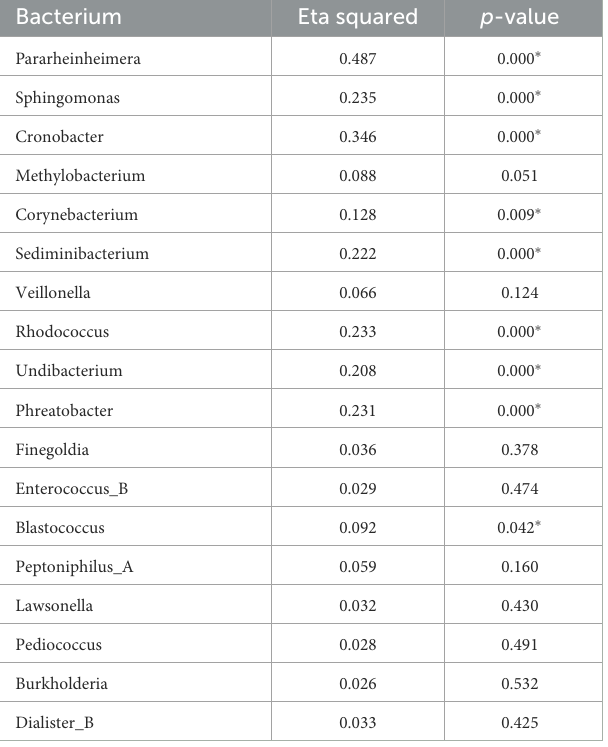
TABLE 2 Contributing bacteria in the four groups.